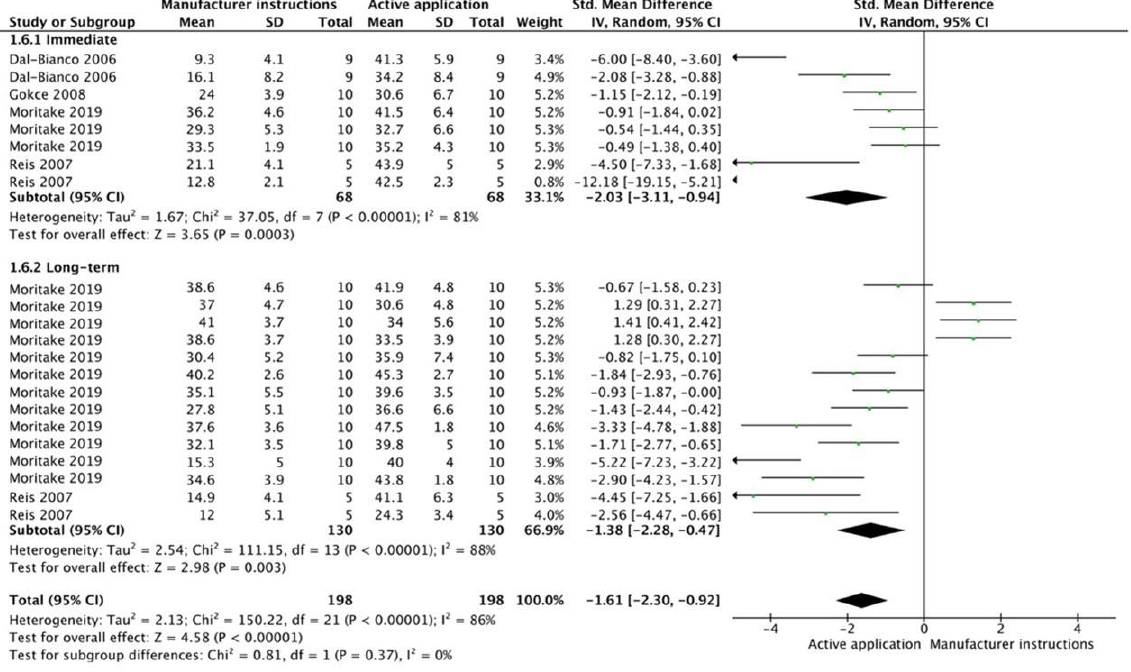
Figure 6. Forest plot showing the bond strength values when the adhesive was used in an active application [84–87].